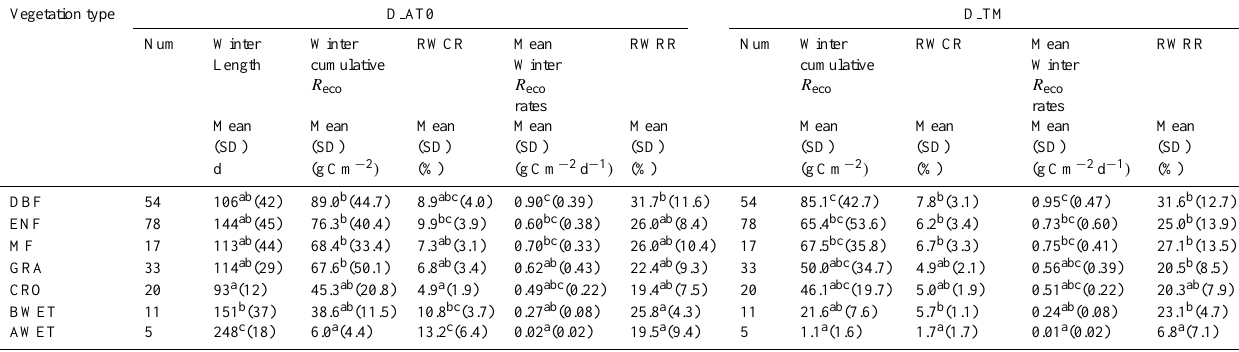
Table 2. Summary statistics of mean winter R eco rates (gCm − 2 d − 1 ) , winter cumulative R eco (gCm − 2 ) . RWRR values (%) and RWCR values (%) with winter definitions D AT0 (air temperature < 0 ◦ C) and D TM (December–February) across ecosystem types. Vegetation type